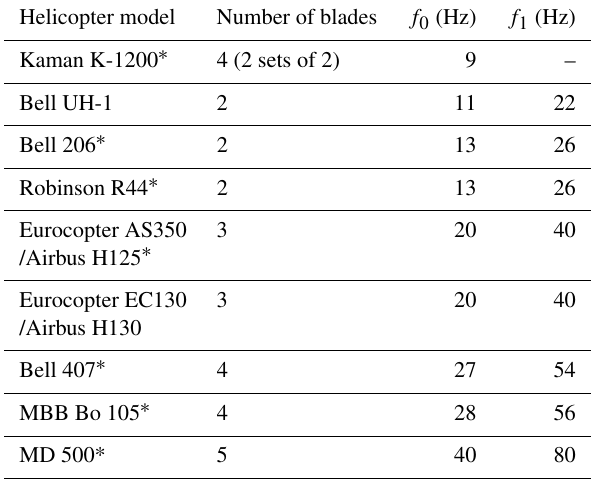
Table 2. Helicopter models, number of main-rotor blades, blade pass frequency ( f 0 ), and first overtone ( f 1 ) of helicopter-sourced infrasound and